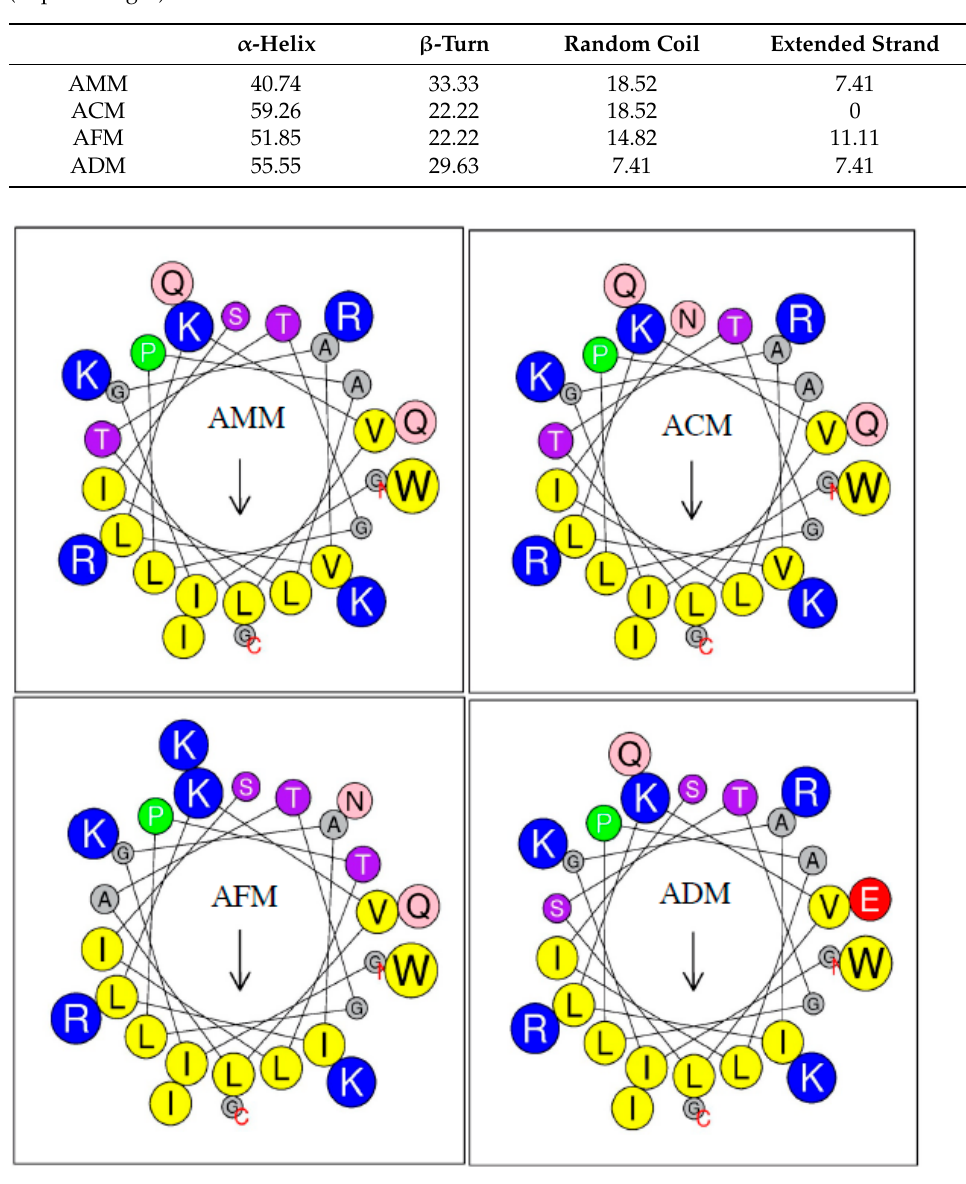
Figure 3. Helical wheel plots of the melittin from four honey bee species. The length of the arrow ( ↓ ) indicates the level of hydrophobicity <H> of the peptide. The size of the letter represents the size of the amino acid side chain. The hydrophilic and hydrophobic portions are labeled in blue and yellow circles, respectively.